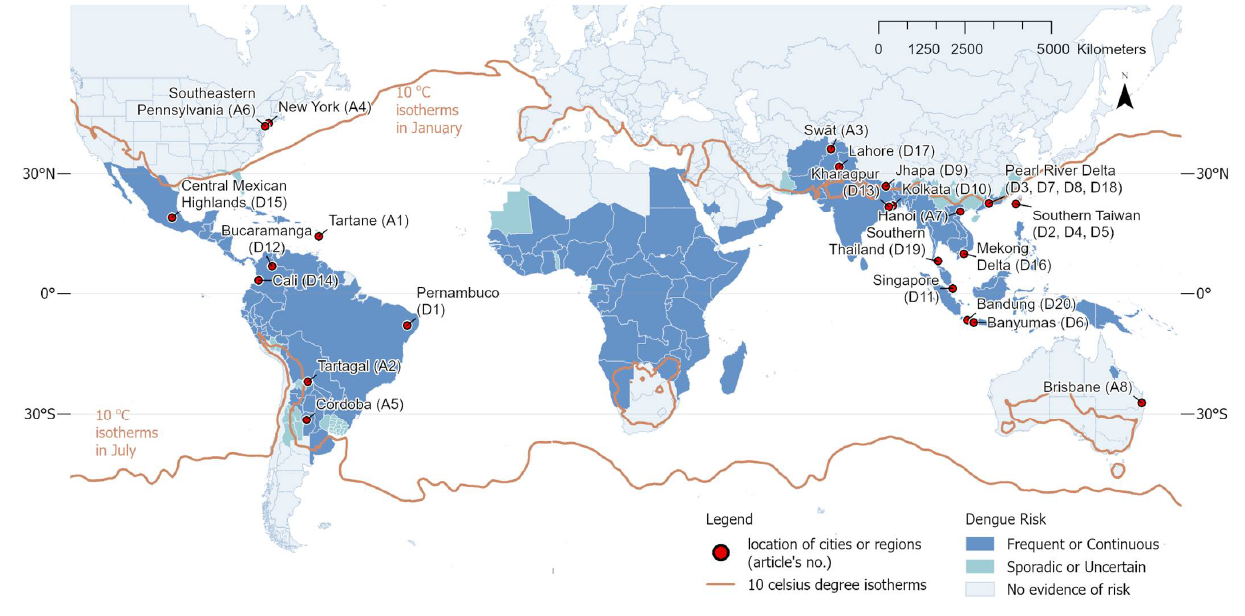
Figure 2. Location of selected studies overlaid with the map of the global dengue burden. The levels of dengue risk are based on reports from the Centers for Disease Control and Prevention, National Center for Emerging and Zoonotic Infectious Diseases, and Division of Vector-Borne Diseases [52]. “Frequent or Continuous” risk means that either frequent outbreaks occur, or transmission is ongo- ing. “Sporadic or Uncertain” risk means that the risk varies and is unpredictable, and that country- level data is not available. The 10 °C isotherms in the winter season were generated using the mean